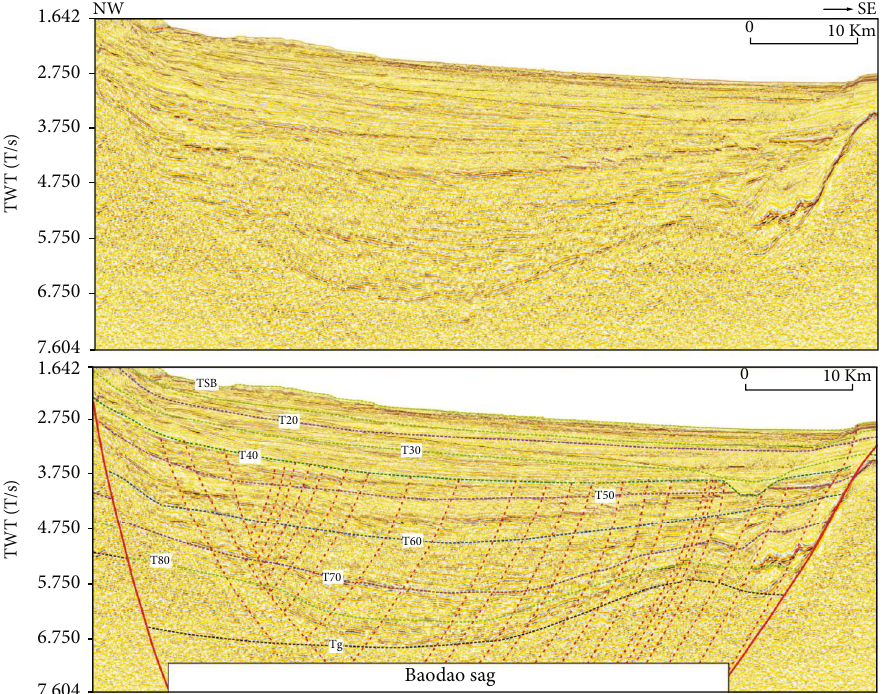
Figure 10: Seismic pro fi le showing the characteristics of the Paleogene and Neogene faults in Eastern QDNB (pro fi le location of line 5 is shown in Figure 1).